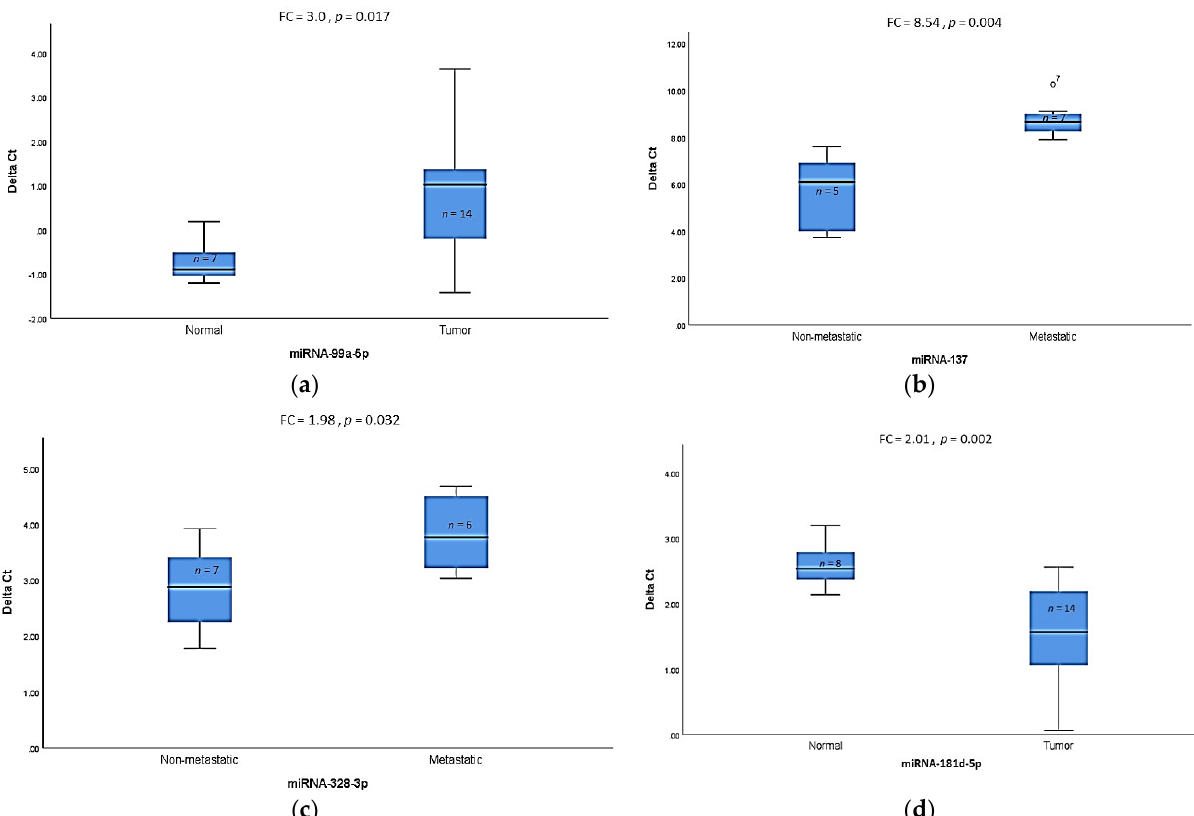
Figure 6. Validation of differentially expressed miRNAs in different PSCC histological subtypes as determined by TaqMan ® RT-qPCR ( p ≤ 0.05). ( a ) Mean ∆ Ct values of (HPV-negative) usual PSCC and normal tissue samples; ( b , c ) mean ∆ Ct values of metastatic versus non-metastatic usual (HPV-negative) tumors; ( d ) mean ∆ Ct values of warty–basaloid (HPV-positive) PSCC versus normal tissue samples. Lower ∆ Ct implies higher expression level. Mann–Whitney U test was used to determine p -values, FC: Fold change.